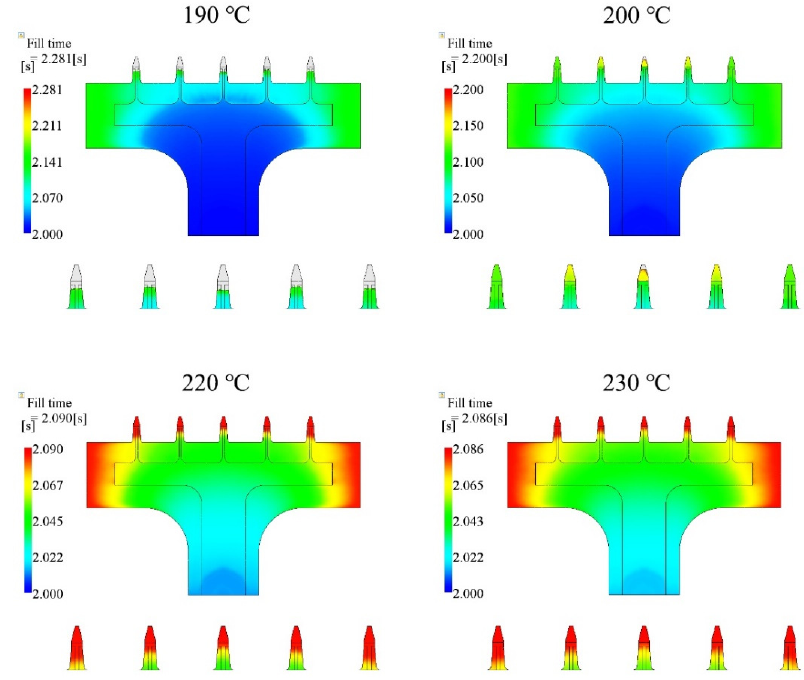
Figure 6. Filling contours for different melt temperature cases.